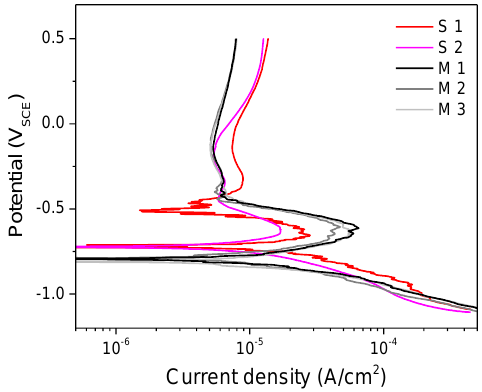
Figure 5. Potentiodynamic polarization curves.